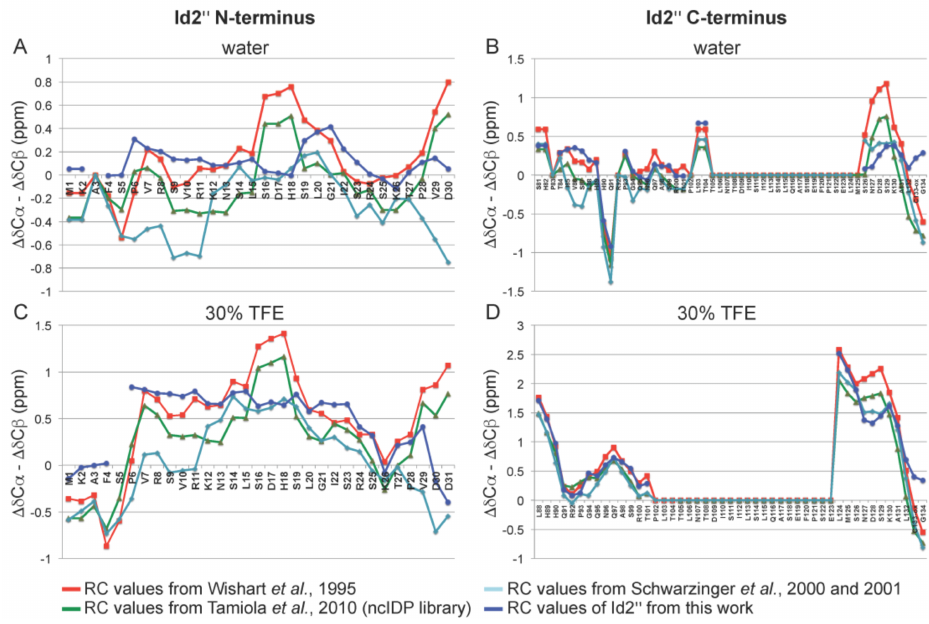
Figure 4. Secondary chemical shifts (deviations of the chemical shifts from the RC values) of 13 C, 15 N-Id2” in water at the concentration of 0.86 mM ( A and B ), and water/TFE (70:30, v / v ) at the concentration of 0.5 mM ( C and D ). The reference random coil (RC) values were from Wishart et al. (obtained from GGXAGG or GGXPGG in 1 M urea at pH~5) [41], Schwarzinger et al. (obtained from GGXGG in 8 M urea at pH 2.3 and neighbor corrected for 13 C α ) [39,40], Tamiola et al. (obtained from IDPs and neighbor corrected, except for Cys-ox, which were from Wishart et al. [41]) [42], and this work (obtained from the Id2” sample in 8 M urea at pH 2.3). The secondary chemical shifts were smoothed by a three-point function